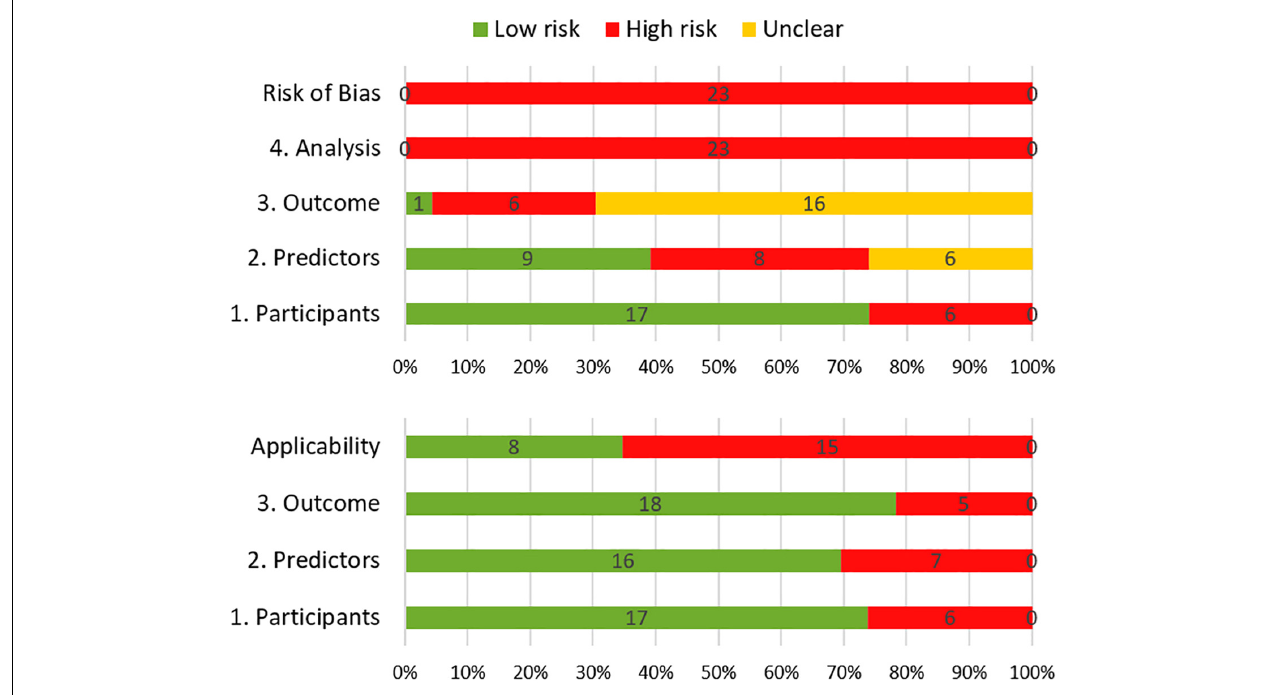
FIGURE 3 | Summary of risk of bias (top) and applicability (bottom) according to the Prediction model Risk Of Bias